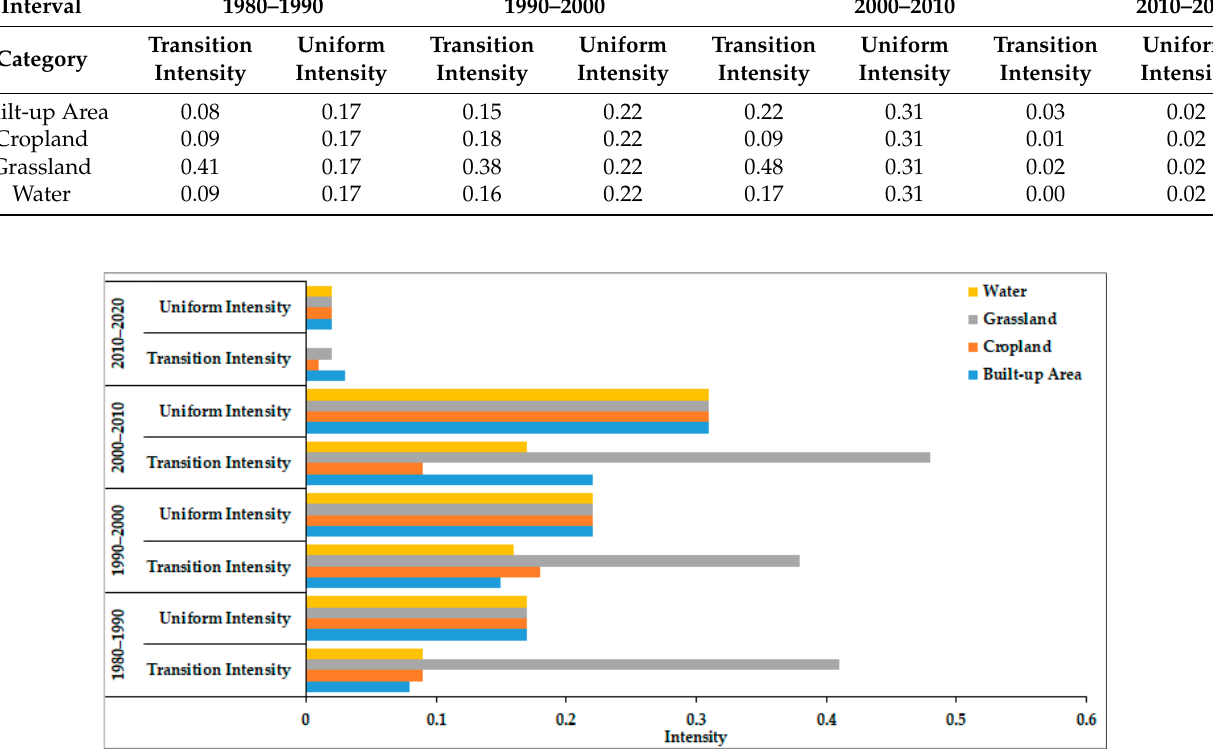
Figure 11. Transition to Built-up Area.